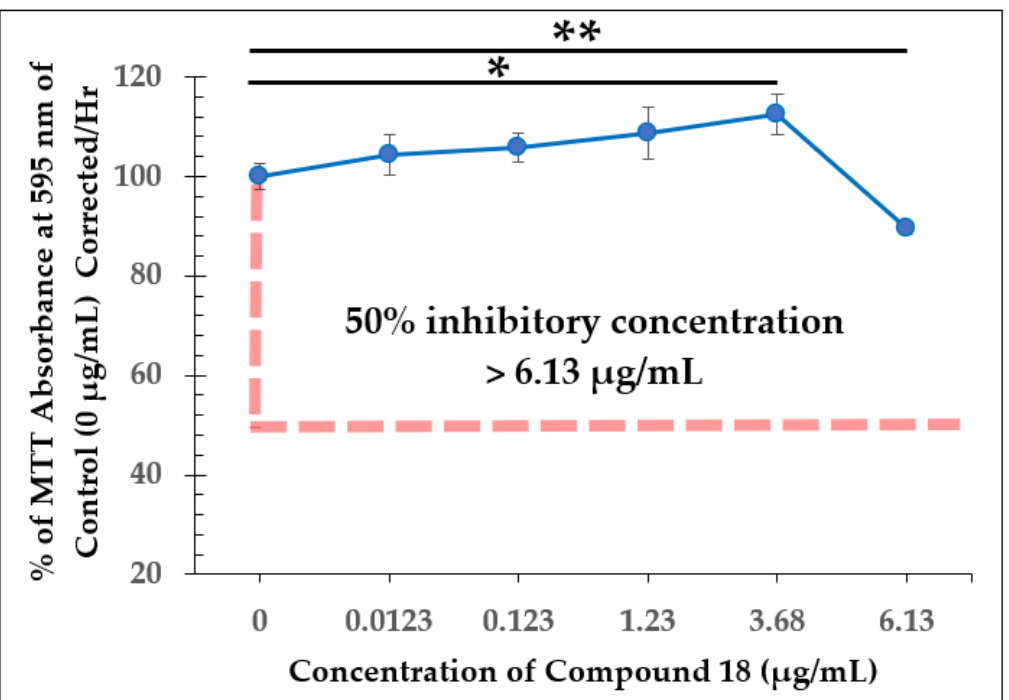
Figure 9. Dose-Dependent Effect of Compound 18 on L. tarentolae Immediately Following Addition (100 h). Values are the mean and standard deviation for n = 4 replicates. * denotes p < 0.05 between 0 µg/mL and 3.68 µg/mL of compound 18 . ** denotes p < 0.05 between 0 µg/mL and 6.13 µg/mL of compound 18 .